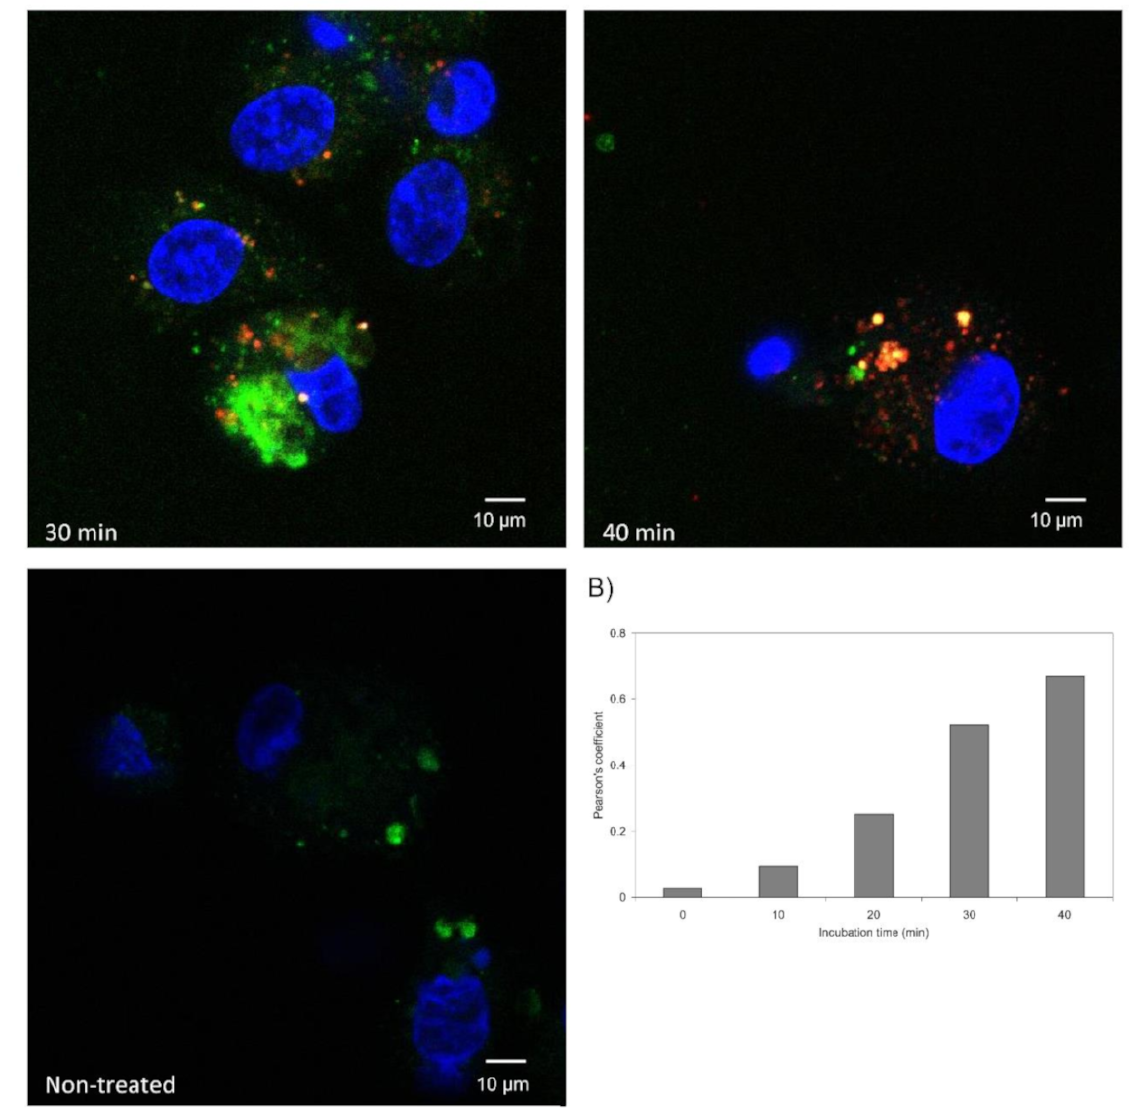
Figure 4. Time-course of the co-localisation of TF-Texas Red with NBD-labelled cholesterol on the cell surface: Human recombinant TF (1 µ g/mL) was labelled with a Texas Red tag using the Innova Lightning-link Texas Red kit according to the manufacturer’s instructions. TF activity was established by fXa-generation assay and TF labelling confirmed before use. ( A ) HDBEC (10 3 ) were seeded into 35 mm glass bottom dishes and labelled using NBD-cholesterol to highlight the cholesterol-rich lipid rafts. The cells were then supplemented with the labelled Texas Red-TF (5.2 ng/mL) and incubated for up to 40 min. The cells were then fixed and stained with DAPI (2 µ g/mL) and were analysed by confocal microscopy at room temperature, using a Zeiss LSM 710 confocal microscope (with a 63 water immersion objective) and images × were acquired using the ZEN software. ( B ) For comparison, co-localisation overlap coefficient values were determined in 10 fields of view from each assay using the ImageJ program.